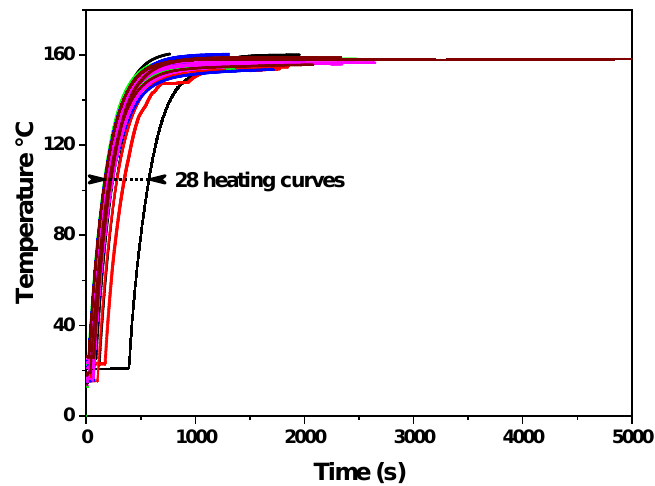
Figure 11. The heating curves show reproducibility and durability in time over a 2-month